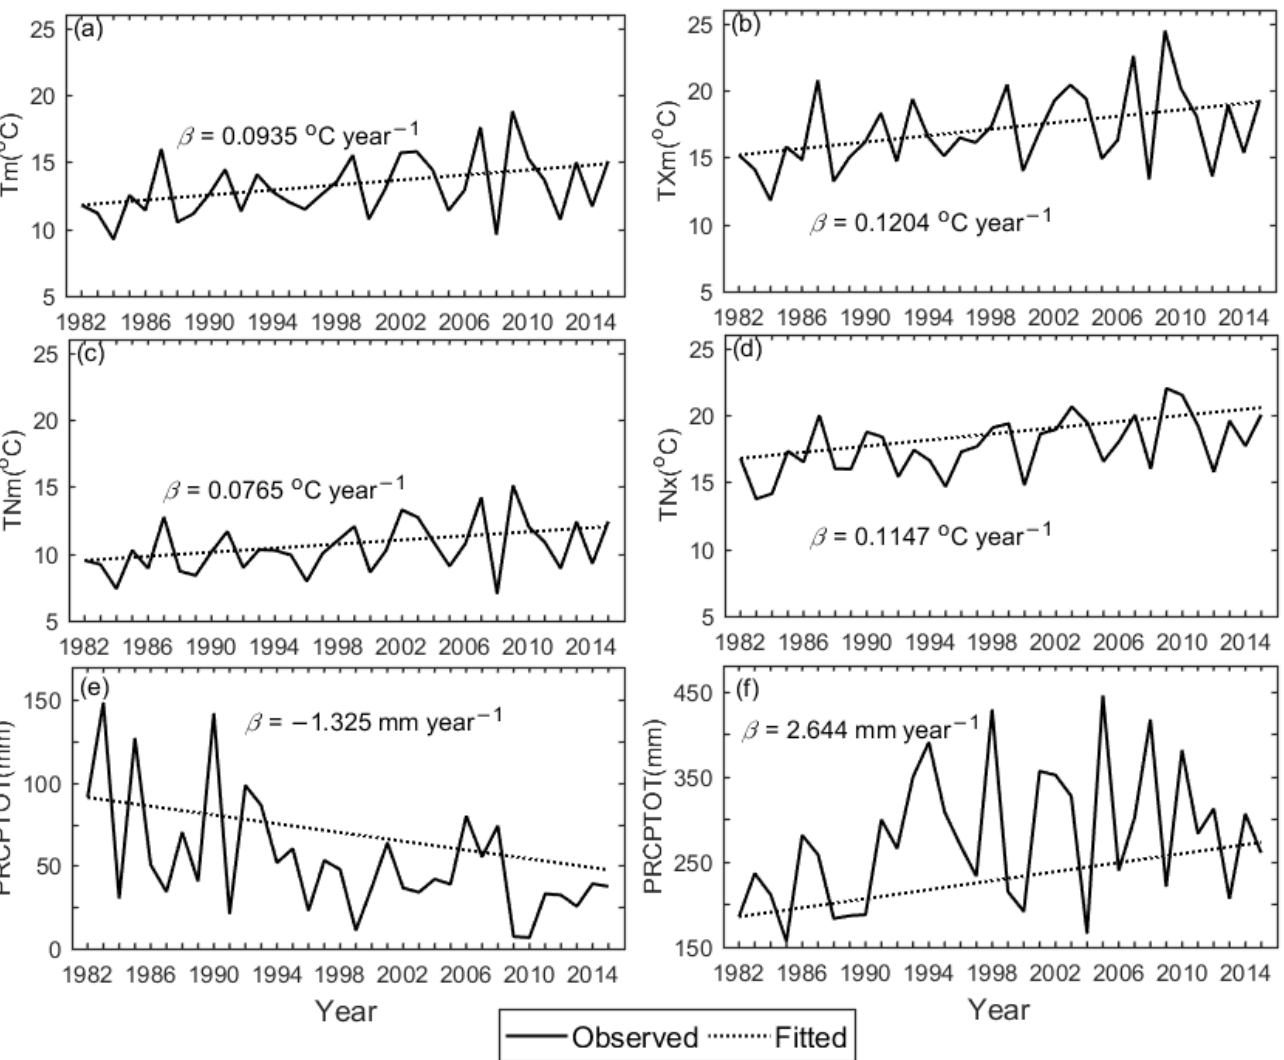
Figure 12. The interannual variation in the monthly climate indices during1982–2015: ( a ) Tm in February, ( b ) TXm in February, ( c ) TNm in February, ( d ) TNx in February, ( e ) PRCPTOT in February and ( f ) PRCPTOT in June. Note: the solid line represents the observed data, and the dotted line represents the fitted